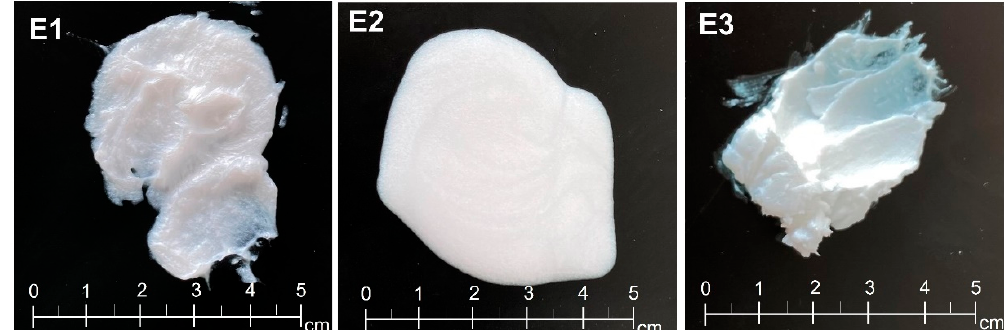
Figure 4. Visual evaluation of consistency of 1 g samples